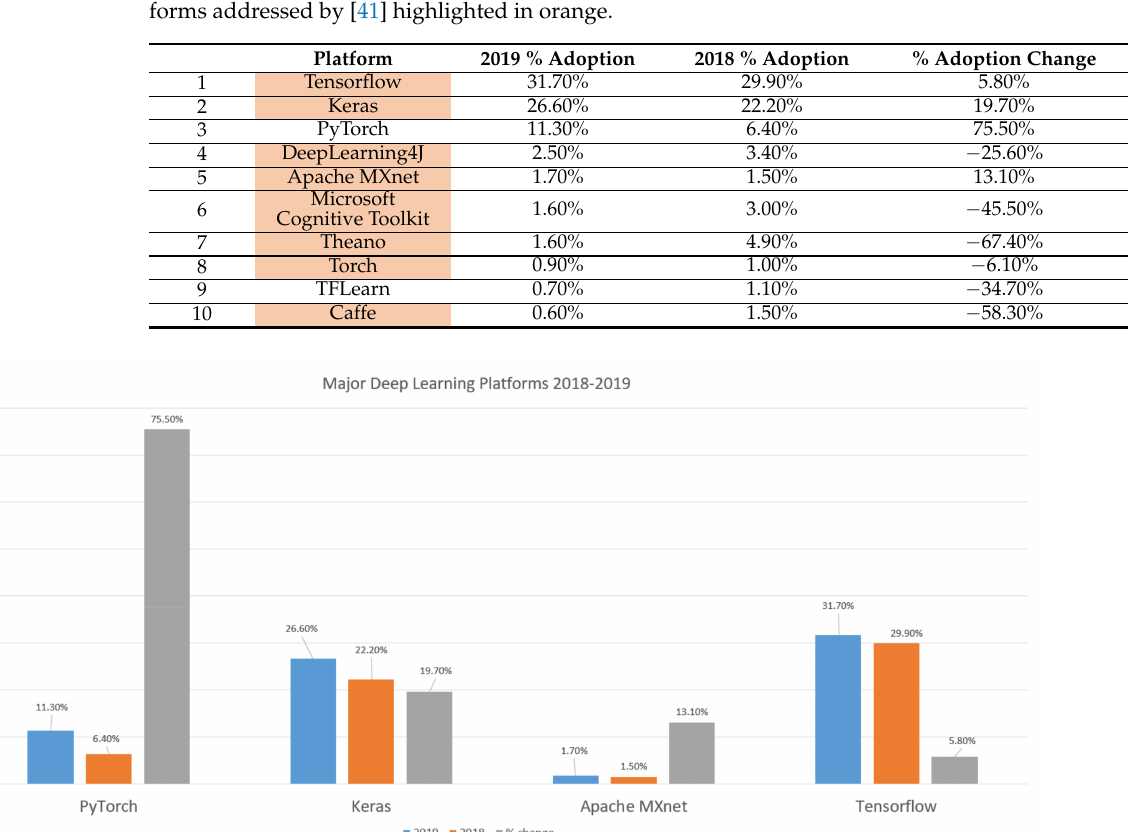
Figure 3. Graphical representation of the highest adoption change (sorted by adoption change %) of deep learning platform as conducted by KDnuggets poll 2018–2019